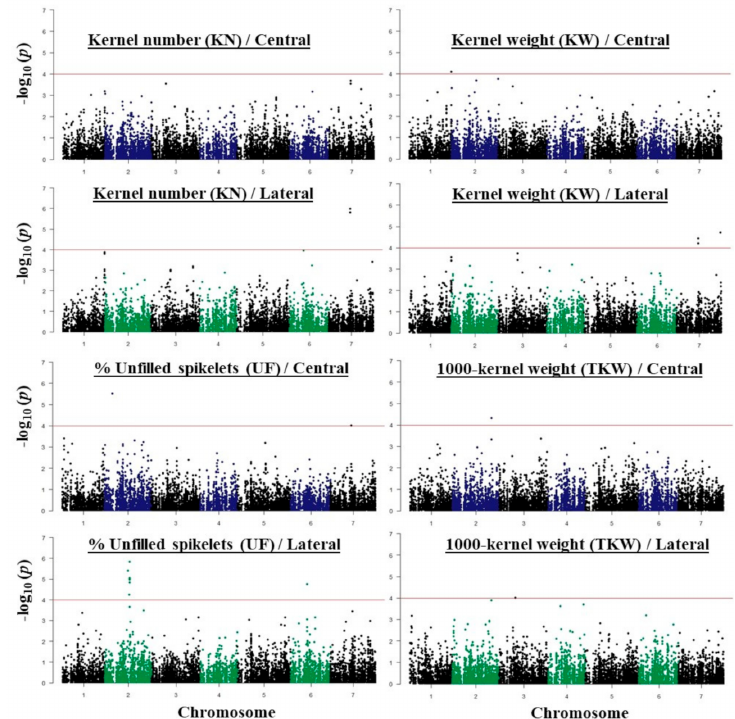
Figure 4. Manhattan plots of genome wide association (GWAS) conducted on kernel number (KN), percentage (%) of unfilled spikelets (UF), kernel weight (KW), and 1000-kernel weight (TKW) for central spikelets and lateral